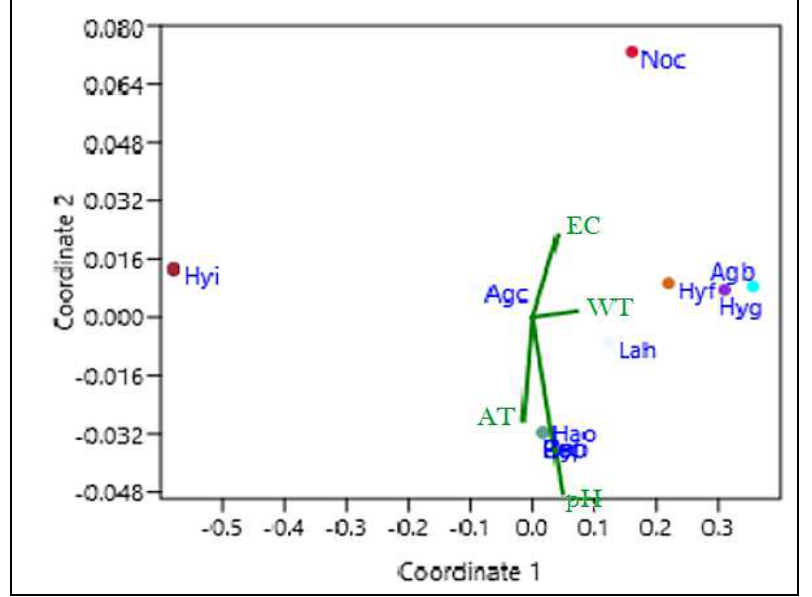
F IGURE 4 .Ordination diagram of the species vs. environmental factors of canonical correspondence analysis